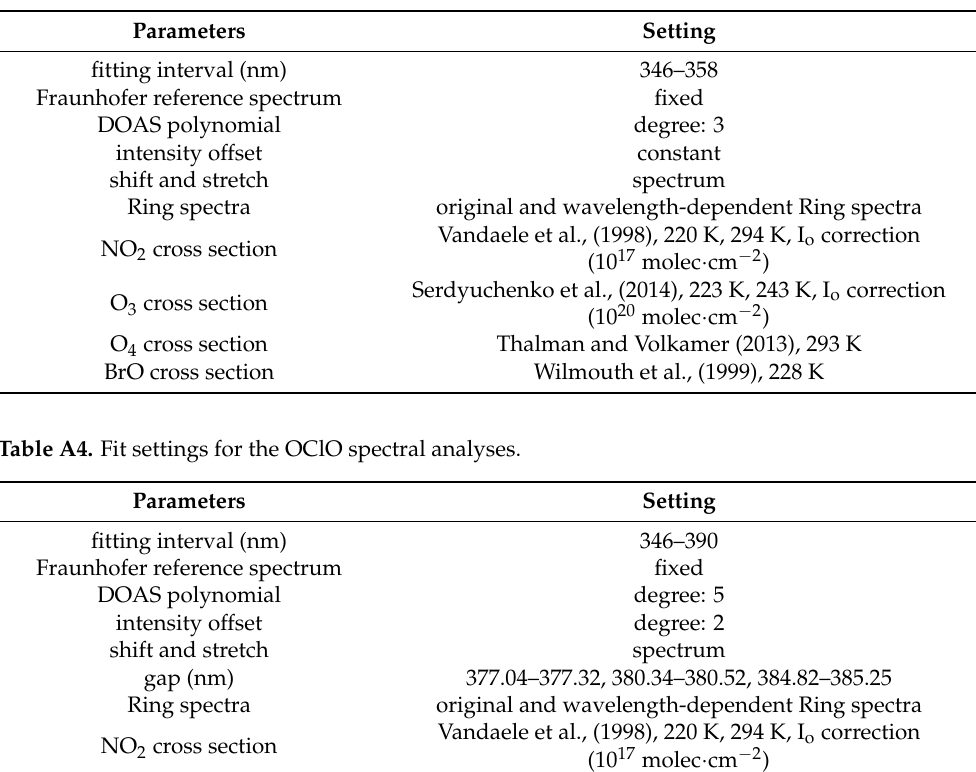
Table A3. Fit settings for the BrO spectral analyses.